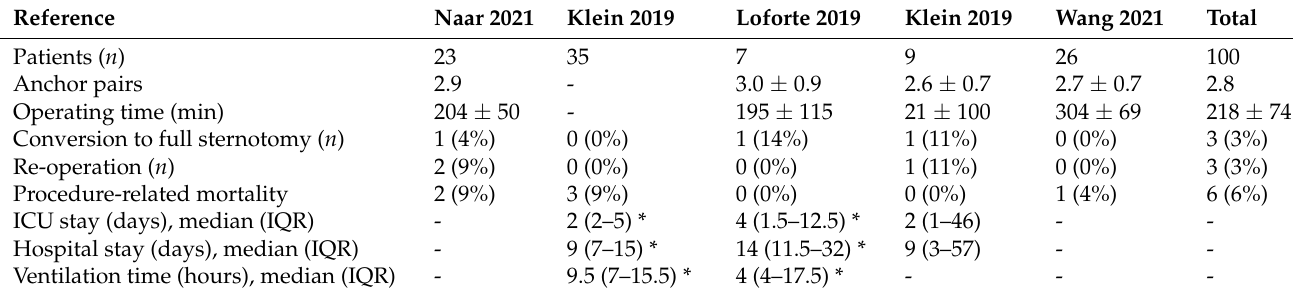
Table 4. Procedural